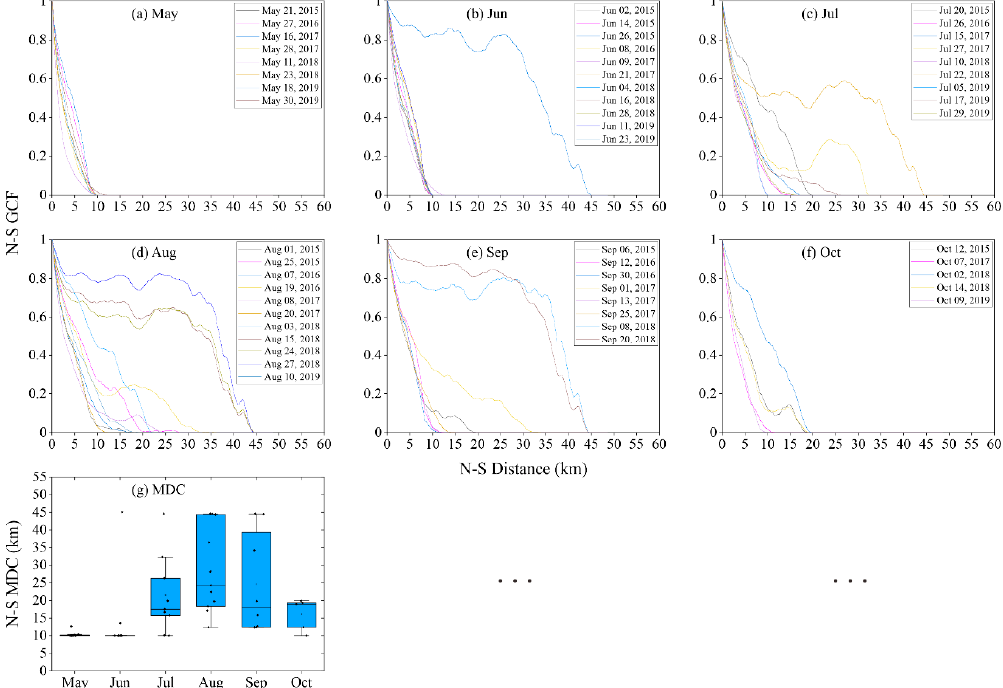
Figure 6. Changes in geospatial connectivity function (GCF) and maximum distance of connection (MDC) in the N–S direction of the Momoge National Nature Reserve, China from 2015 to 2019. ( a – f ) indicate May to October and ( g ) indicates